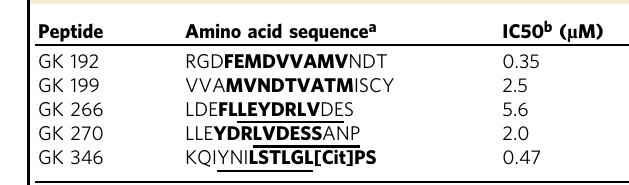
Table 1 Sequences and binding af fi nities for antigenic glucokinase